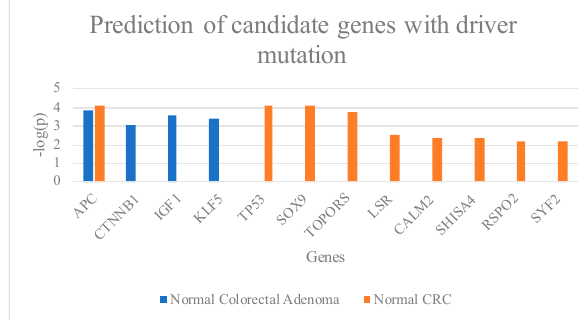
Figure 5. Prediction of candidate genes with driver mutations from normal - colorectal adenomatous polyps and normal - CRC .